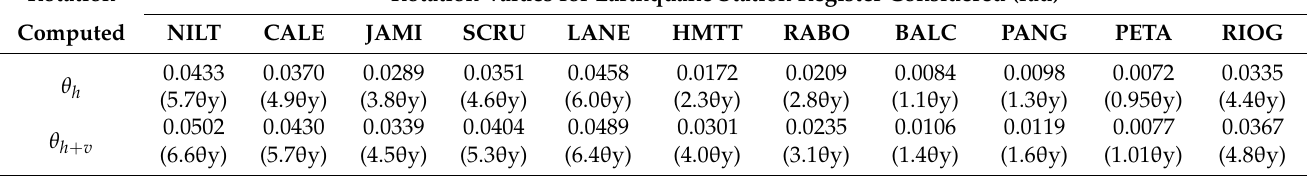
Table 11. Rotations generated by horizontal earthquake components and by horizontal and vertical earthquake components acting together (8-story